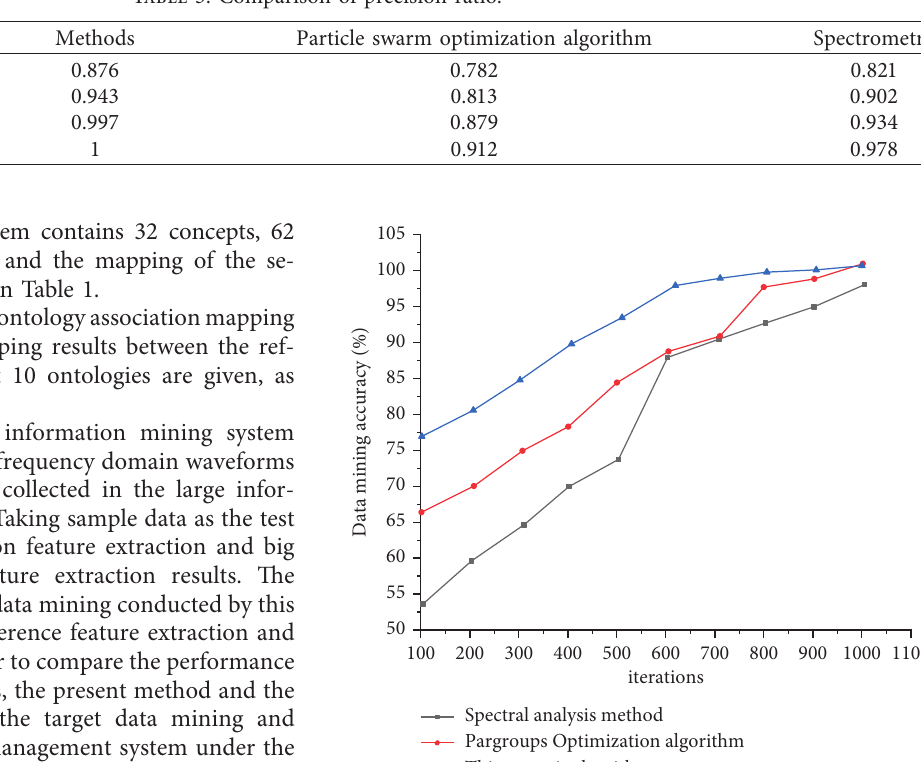
Table 3: Comparison of precision ratio.